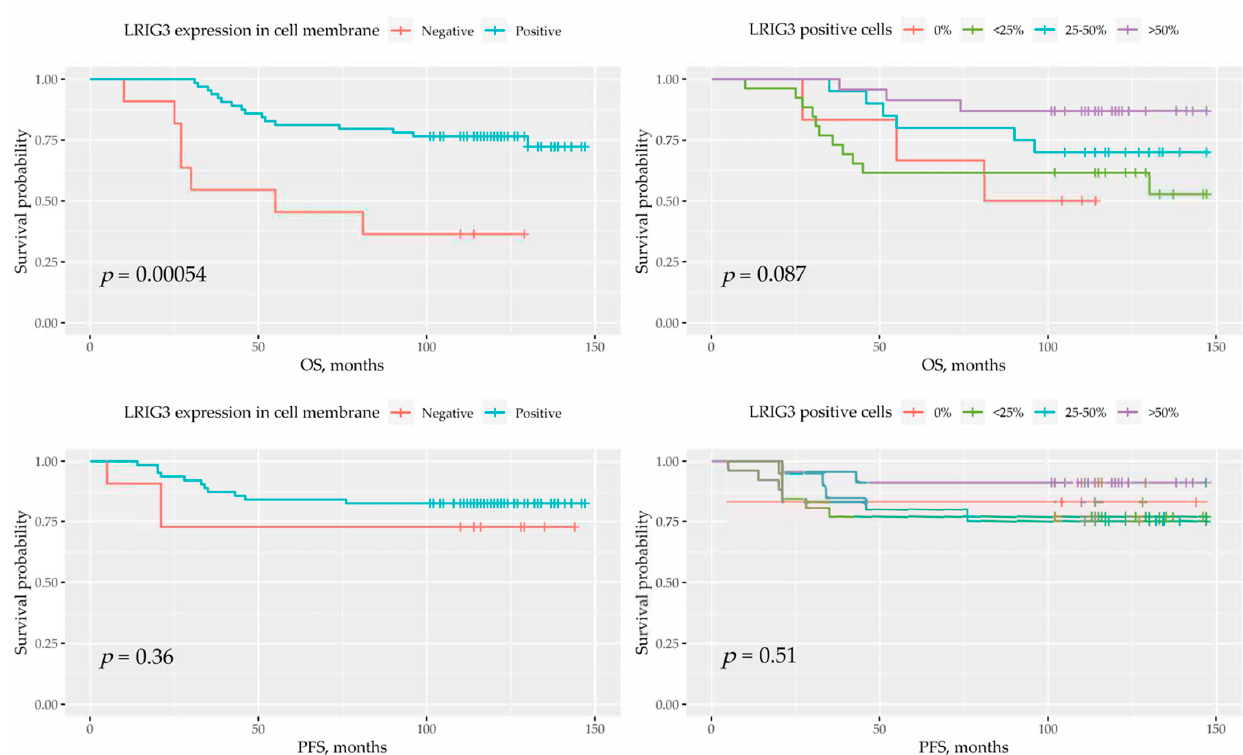
Figure 5. Percentage of LRIG3-positive cells and LRIG3-positive staining of the cell membrane in women who died and in endometrial cancer survivors.